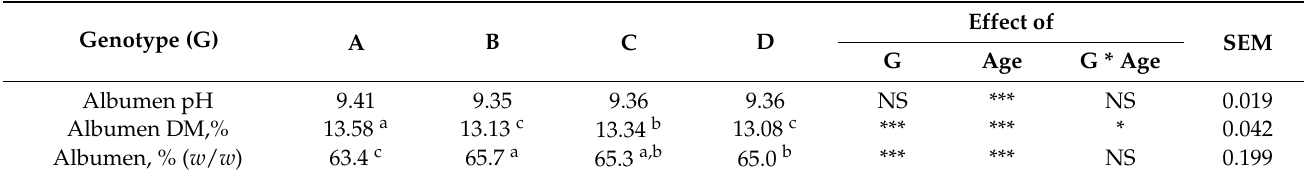
Table 4. Effect of hen genotype A, B, C, and D, age, and their interaction on LS-means of egg albumen parameters between the 21st and 54th week of age, n = 180 for genotype A and 270 for genotypes B, C and D.